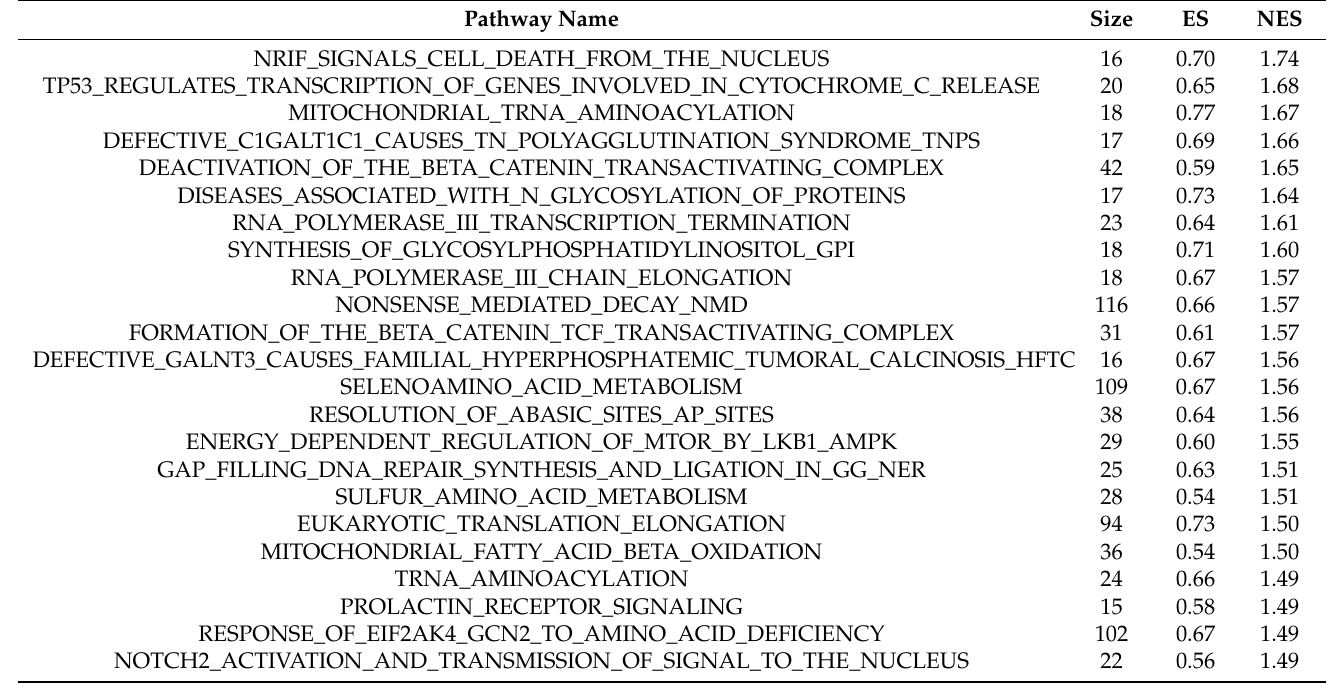
Table 5. REACTOME pathways showing a normalized enrichment score (NES) > 1.48 in GSEA Analysis II.